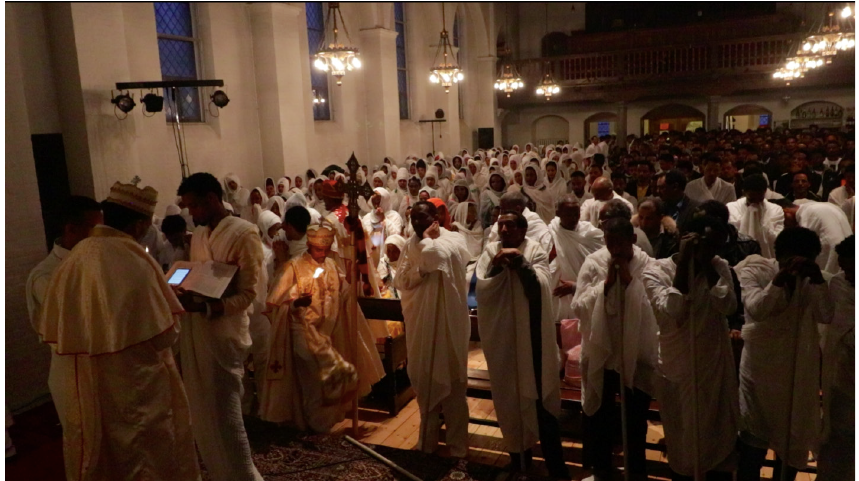
Figure 8. Easter celebration at Blågårds Church in Copenhagen. The priest reads aloud from a smartphone. April